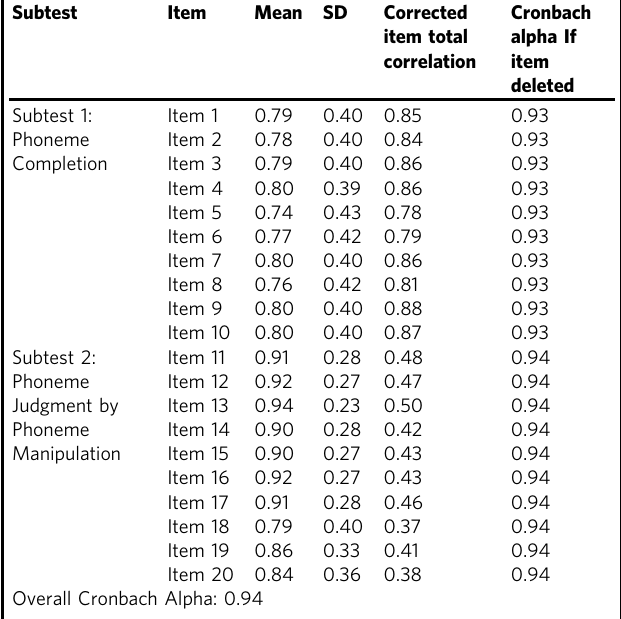
Table 1 Results of item